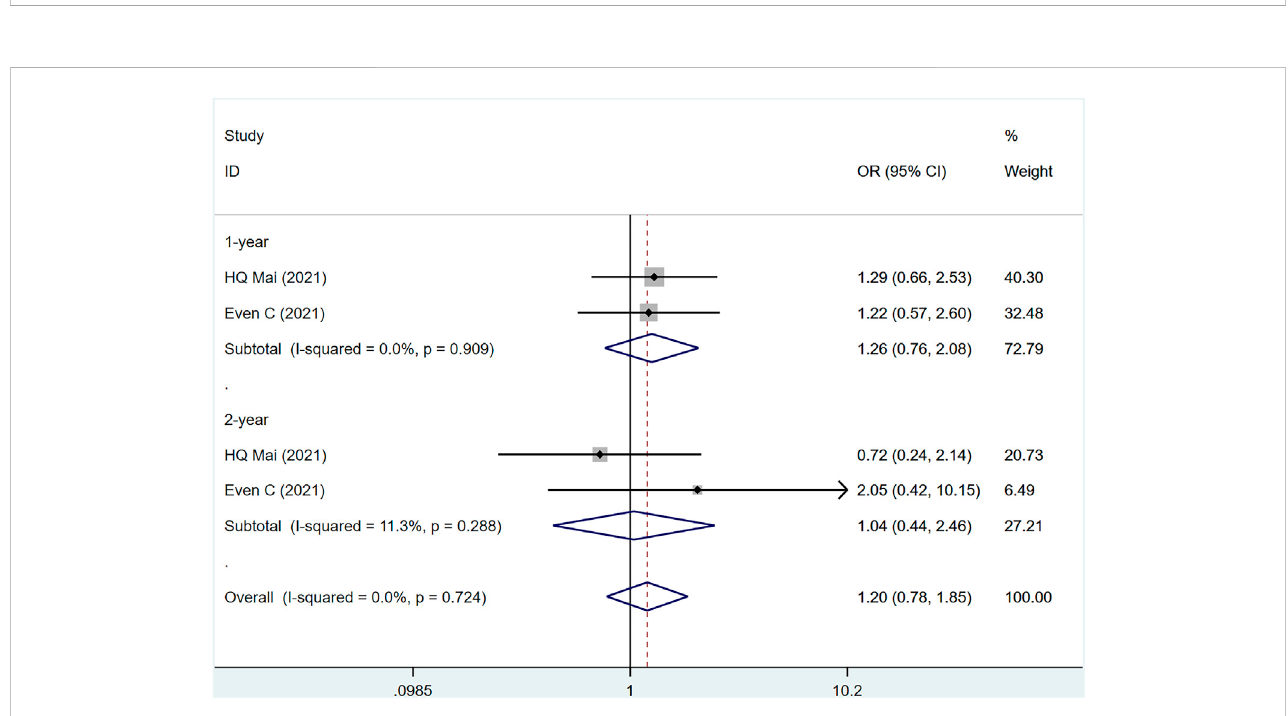
the potential heterogeneity may originate from Even C (23) (Supplementary Figure S2A). p -values for assessing publication bias (Egger test: .294, Begg test: .117) were all > .05, indicating that there is a small possibility that there is no publication bias (Supplementary Table S4).